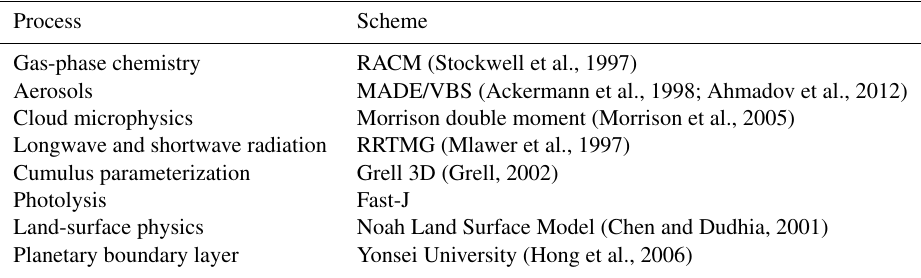
Table 1. Gas-phase chemistry, aerosols, and physics parameterizations used in the